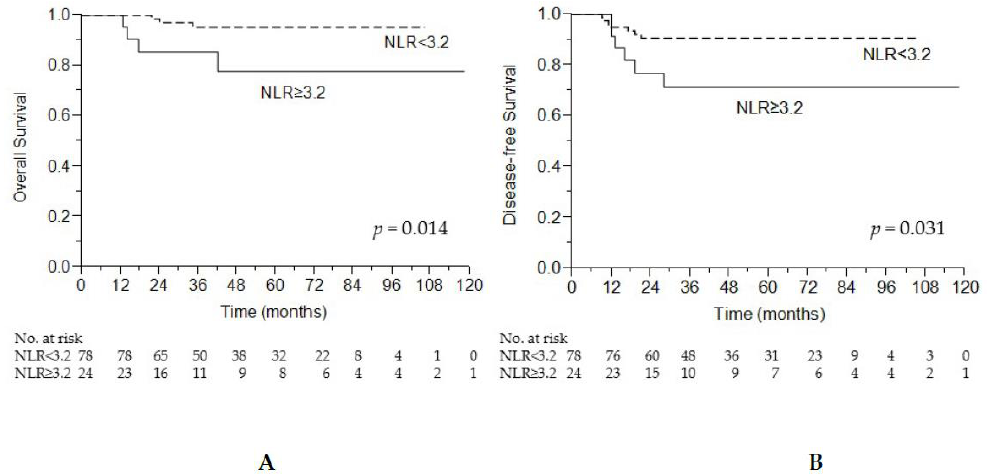
Figure 4. Kaplan–Meier curve depicting overall survival ( A ) and disease-free survival ( B ) according to NLR status.